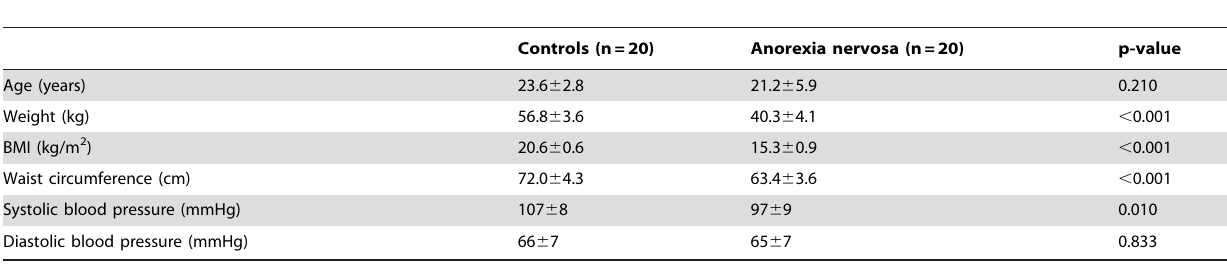
Table 1. Baseline characteristics and anthropometric data for the women participating in the study.